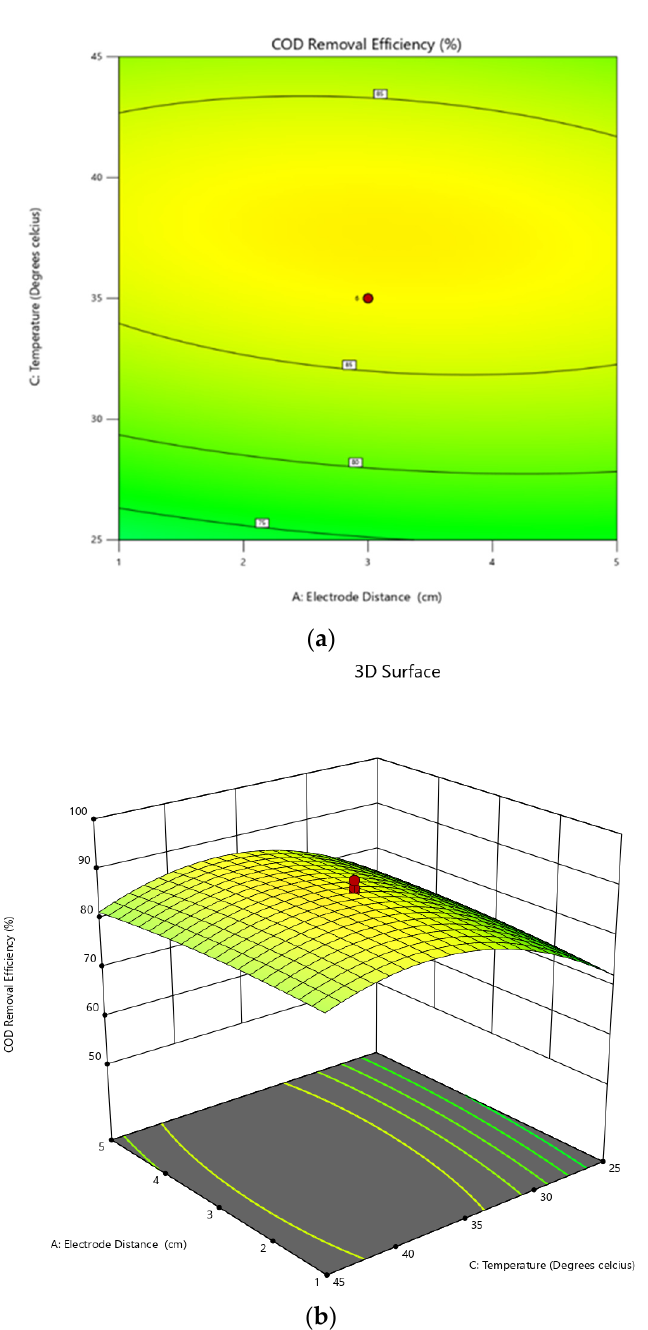
Figure 6. ( a ) Contour plot and ( b ) response surface plot of biomass as a function of moisture con- tent relative to electrode distance.